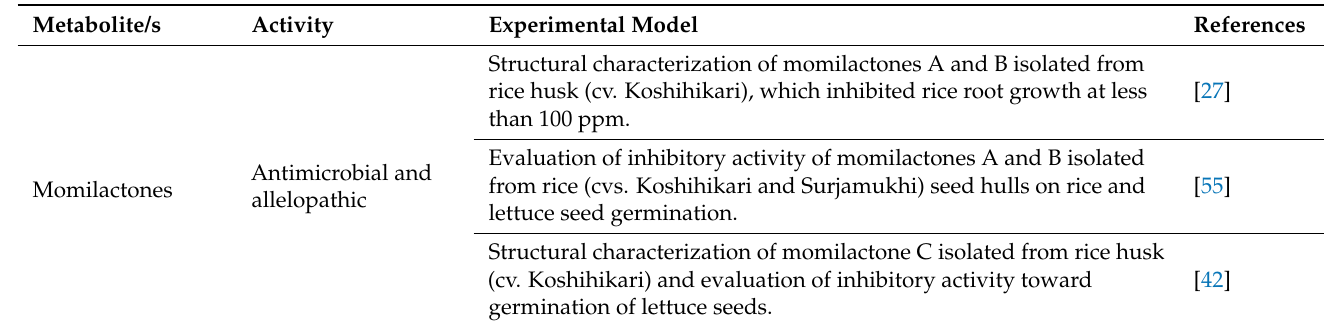
Table 4. Biological activities of rice diterpenoid phytoalexins.